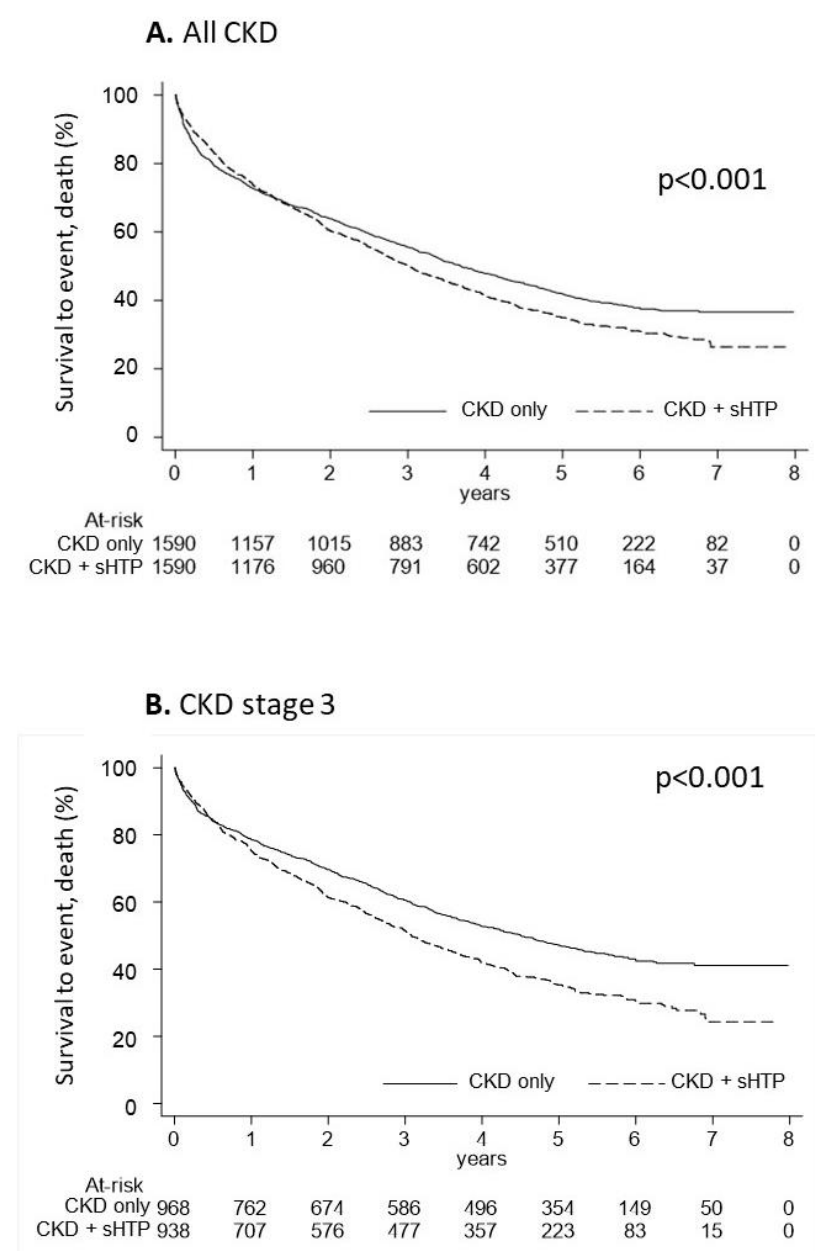
Figure 4. Kaplan-Meier curves for the CKD + sHPT vs. CKD-only groups showing overall survival in all CKD patients ( A ) and in those with CKD stage 3 ( B ).